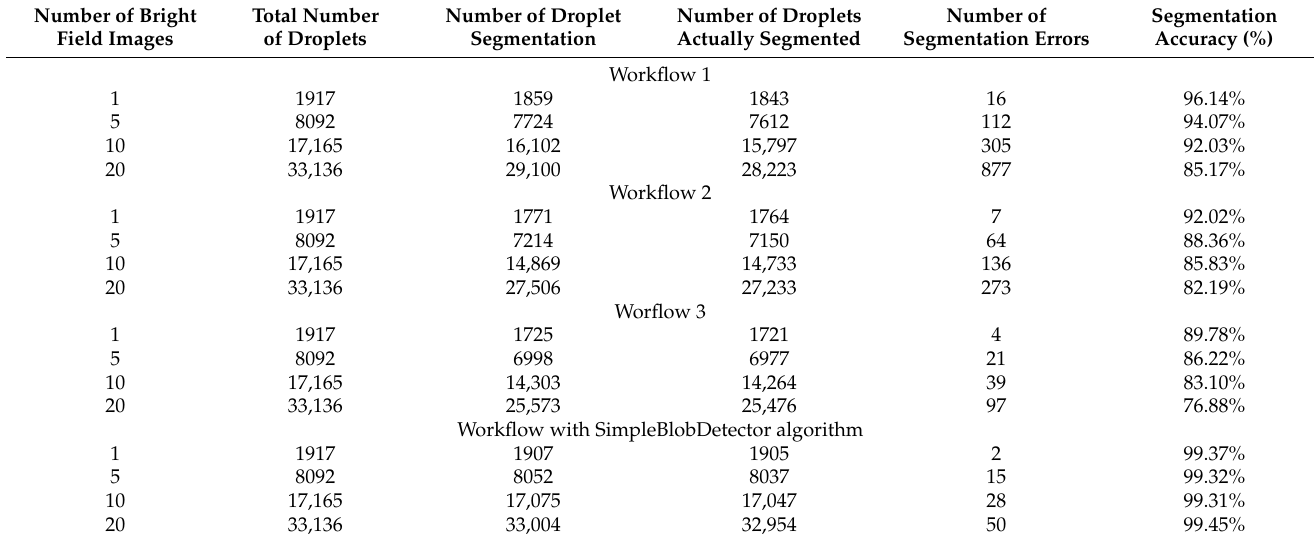
Table 1. Accuracy of bright-field image droplet segmentation for the above three segmentation workflows and workflow with SimpleBlobDetector